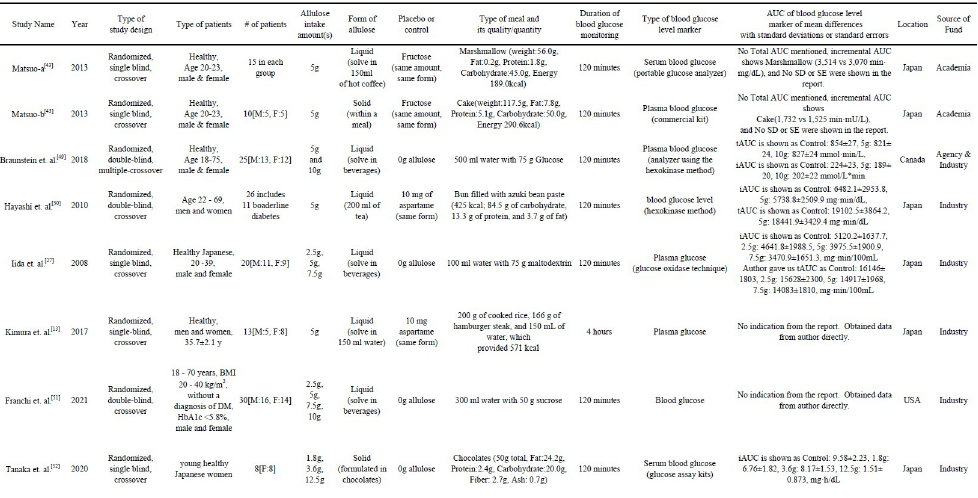
Fig 2. Data extracted from included